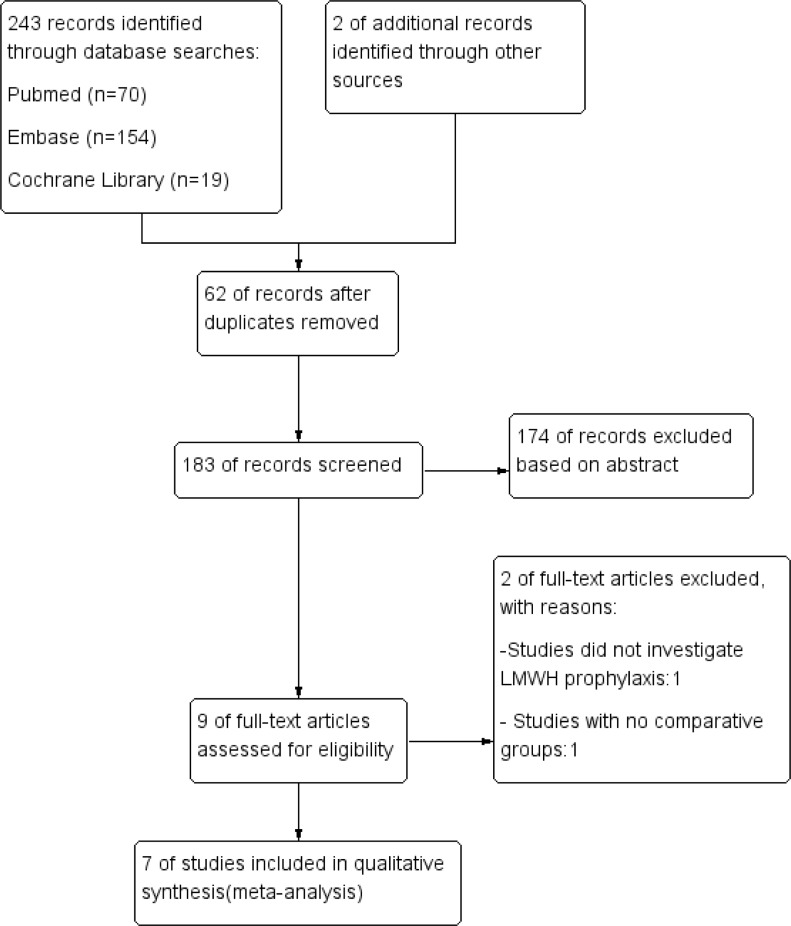
Flowchart of the screened, excluded, and analysed publications.